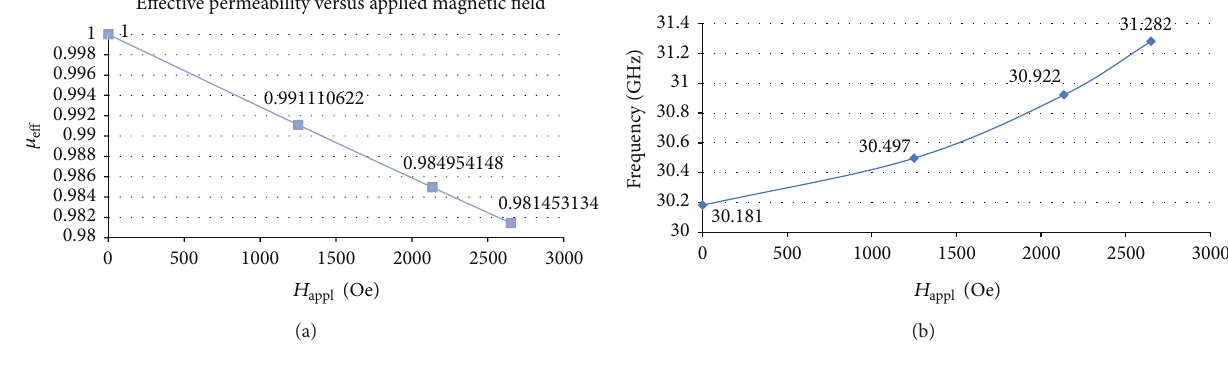
(a) and of the antenna resonant frequency (b) following the sweep of the eff = 0 T to 𝐻 = 0.265 T. appl appl